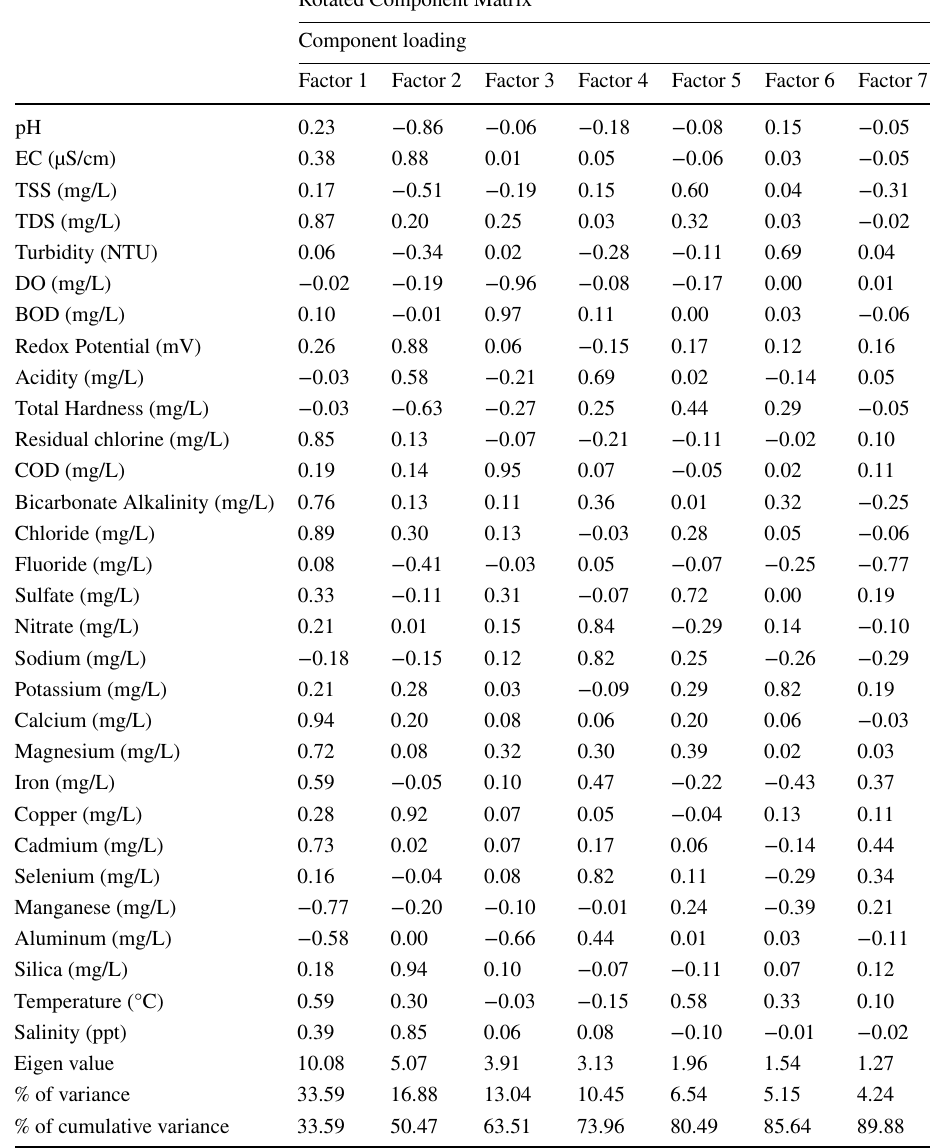
Table 4 Rotated varimax principal component analysis of the water quality